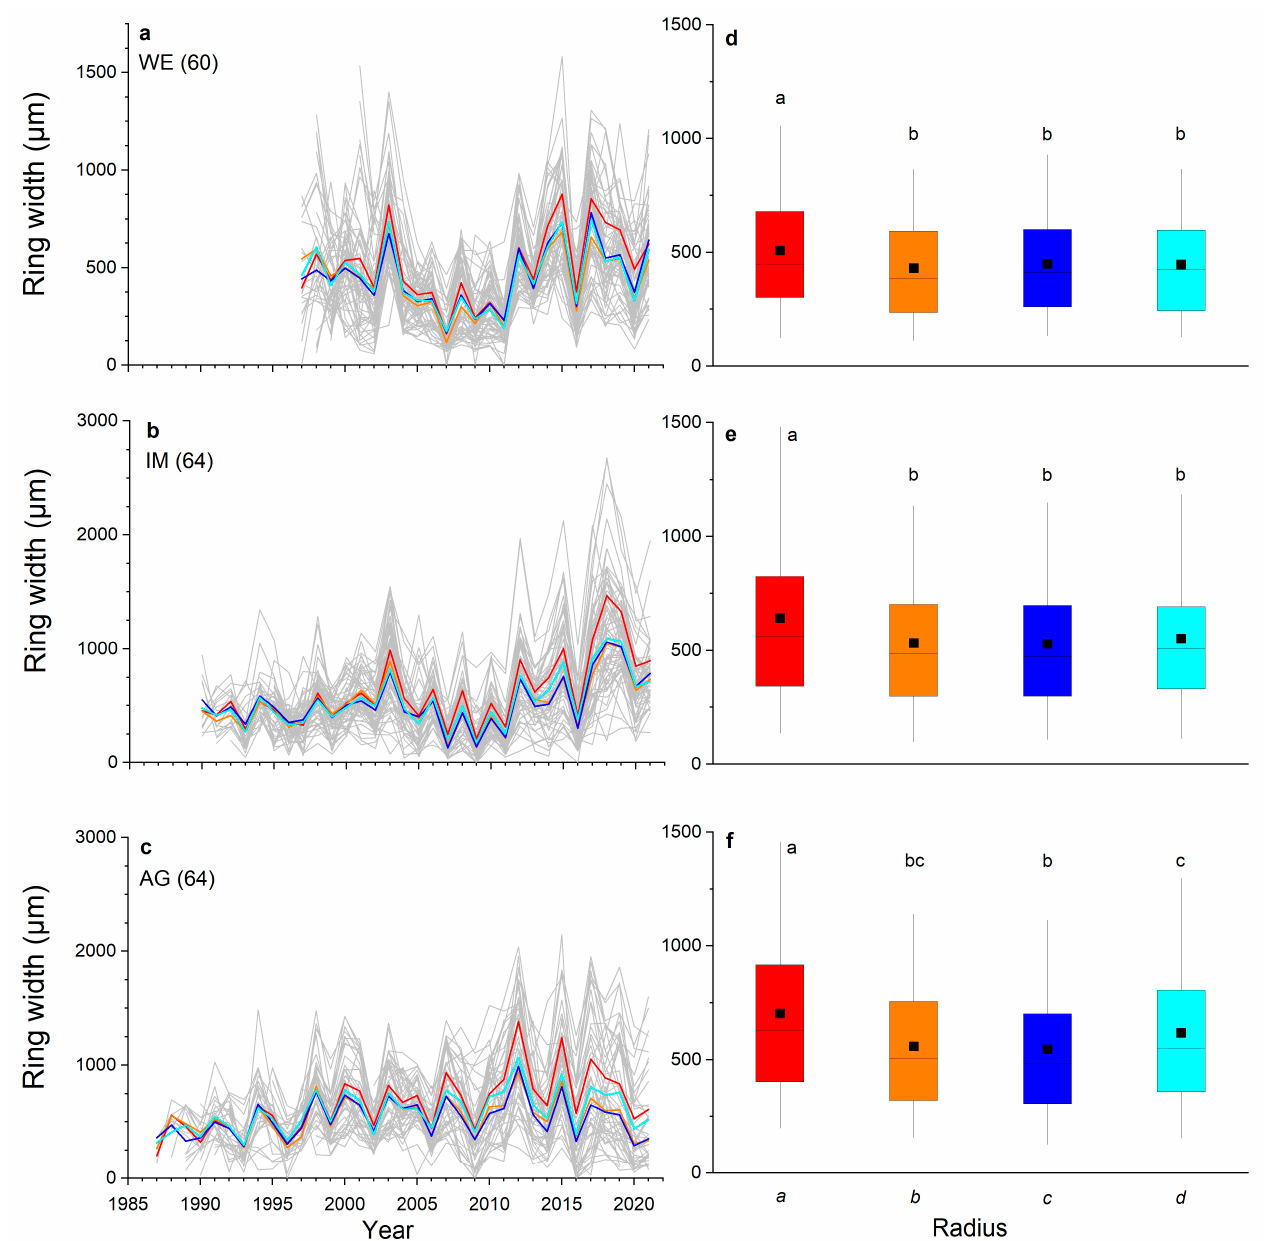
Figure 2. Ring-width series: ( a – c ) of all measured radii (grey lines; number of radii measured per stock are given in brackets) at a wind-exposed ridge (site WE), an intermediate site (IM) and a north- facing avalanche gully (site AG). Mean values of radii are shown in red (radius a ), orange (radius b ), dark blue (radius c ) and light blue (radius d ); ( d – f ) box-plots of ring width of all radii of each stock. The fi lled square and line indicate the mean and median ring width, respectively, the upper extent of the box indicates the 75th percentile, the lower extent indicates the 25th percentile and whiskers represent the 5th and 95th percentile. Statistically signi fi cant di ff erences of mean values between radii are indicated by di ff erent le tt ers ( p ≤ 0.01; Student’s t -test).